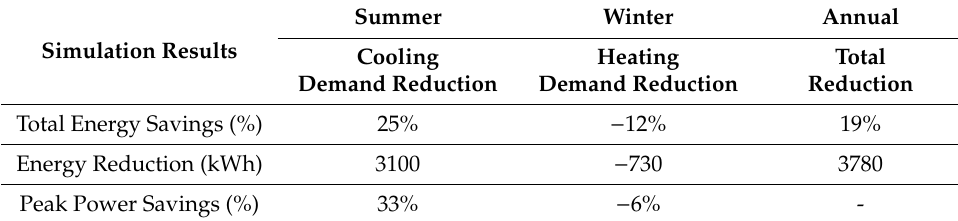
Table 5. Simulation results in energy savings (green roof vs. conventional rooftop).